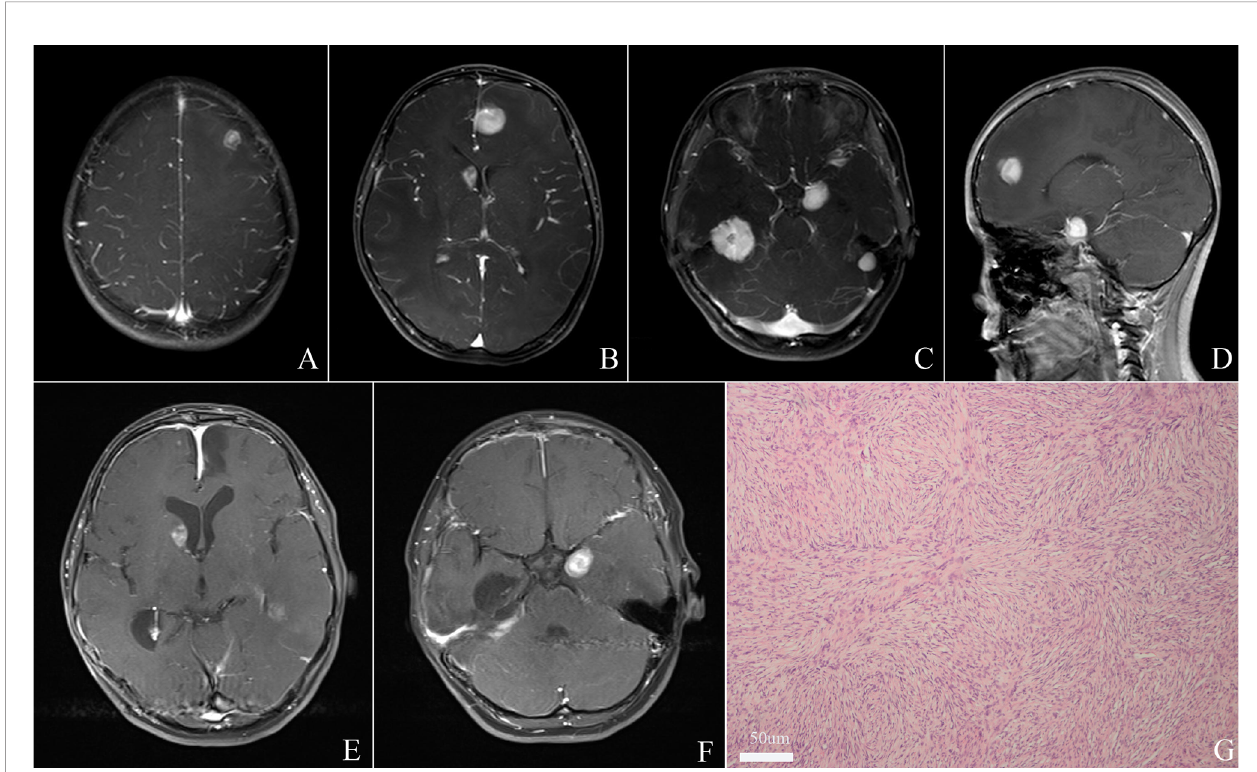
FIGURE 1 | Cranial magnetic resonance imaging (MRI) depicted fi ve lesions located in the right and left tentorium, left para sellar, right lateral ventricle, and left frontal lobe respectively (A – D) . Total resection of tumors in the left frontal lobe and right tentorium was achieved (E, F) . Histopathological examination revealed a desmoplastic spindle cell tumor with highly eosinophilic collagenous fi ber, con fi rming the diagnosis of DIA/DIGs. (x 200) (G)